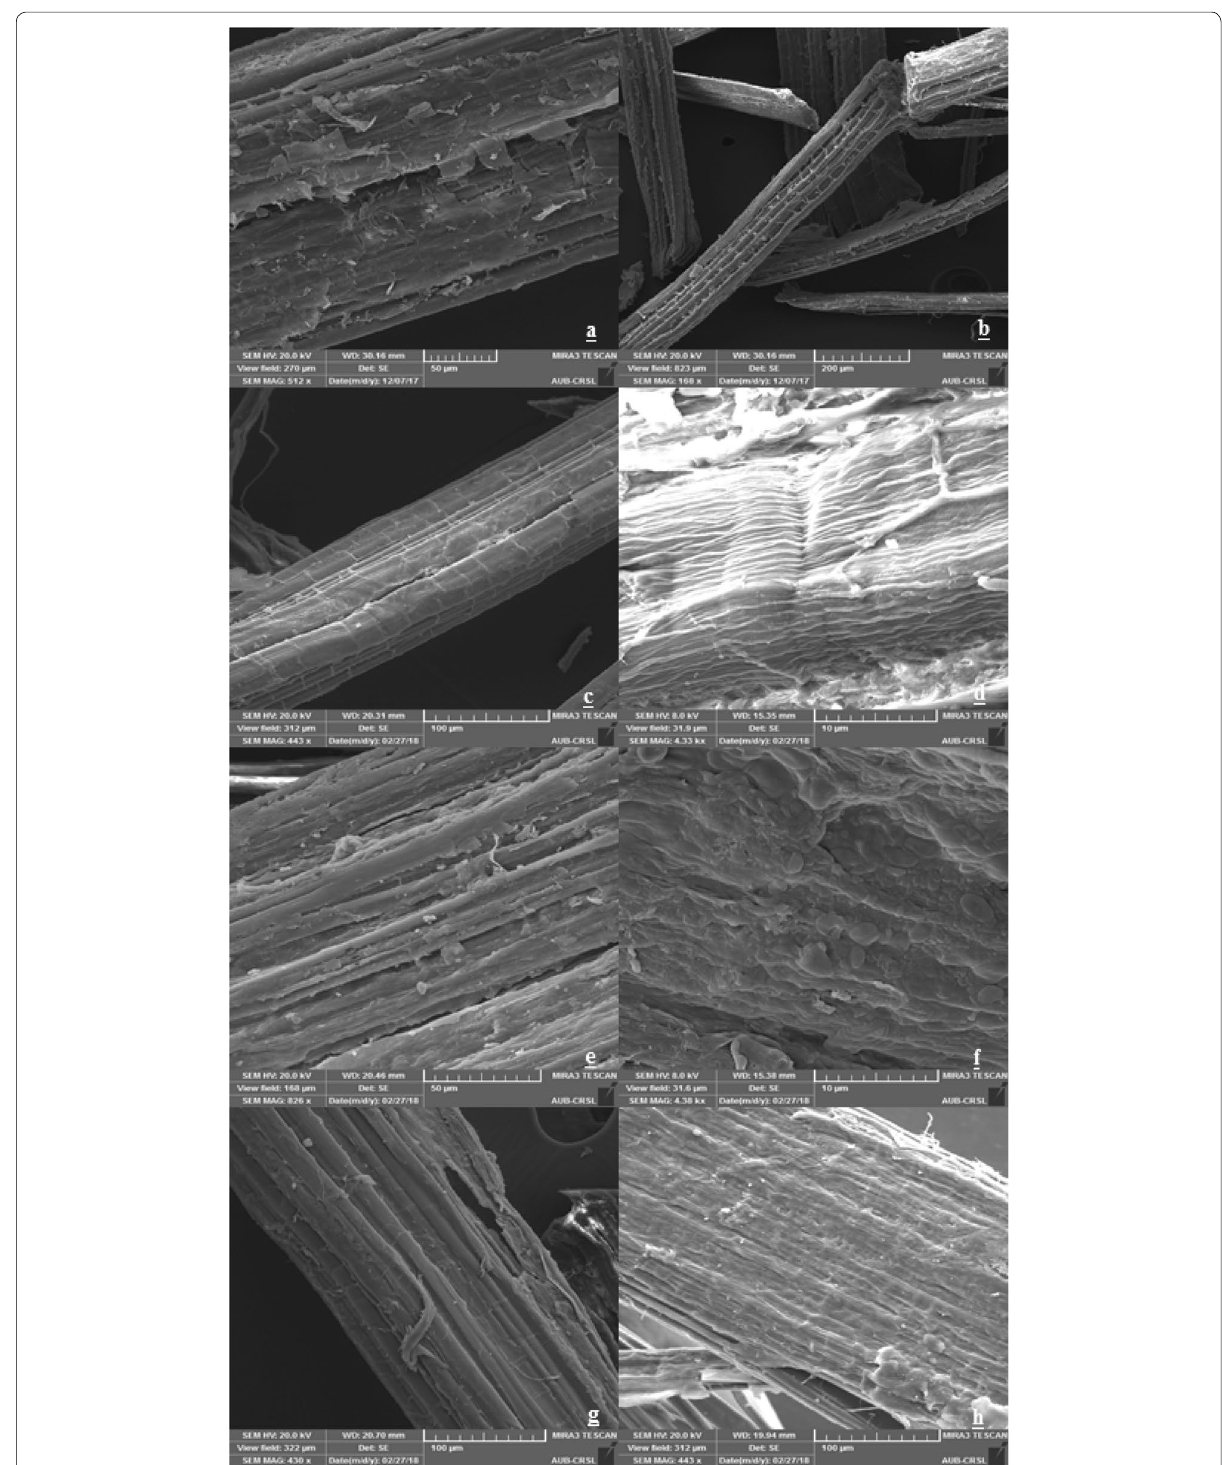
Fig. 3 SEM imges of the hemp